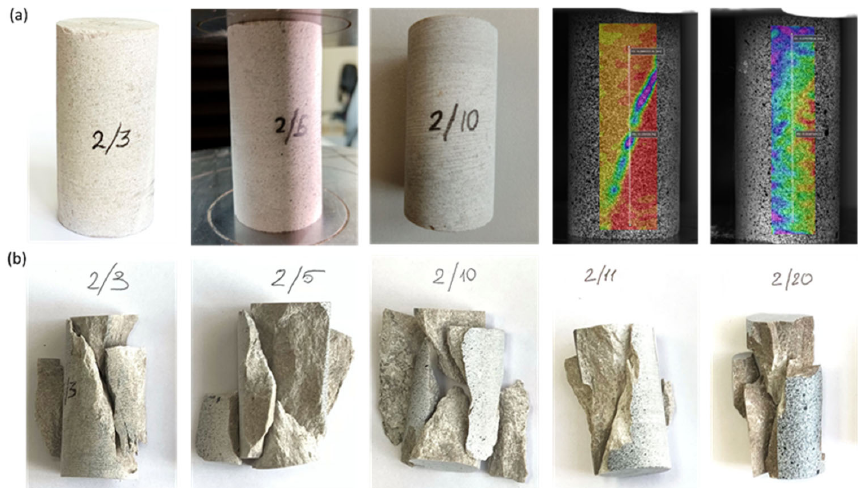
Figure 6. Photographs depicting air-dried samples during testing for uniaxial compression: ( a ) samples before failure; ( b ) samples after testing demonstrating different failure modes, such as Y-shaped (samples 2/3, 2/5 and 2/20), double shear (sample 2/10) and shear along a single plane (sample 2/11). Similarly, samples saturated with distilled water were studied for uniaxial compres ‐ sion (Figure 7a). Samples 2/18, 2/32 and 2/45 were painted with speckles before testing. During the loading test, the standard failure modes of the samples were also observed, as shown in Figure 7b.